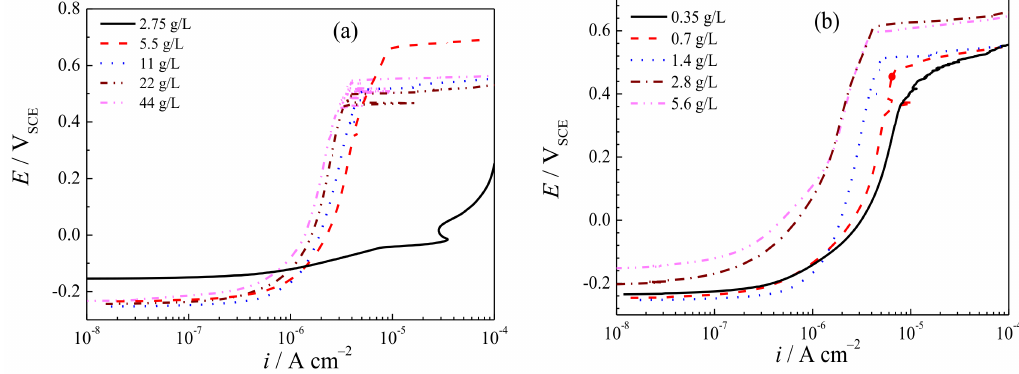
Figure 6. Influence of compositions on N D in the passive films of the low-nickel stainless steel in groundwater solution, ( a ) A1–A5 solutions with different concentration of SO 42 − , ( b ) B1–B5 solutions with different concentration of HCO 3 − , and ( c ) C1–C3 solutions with different pH